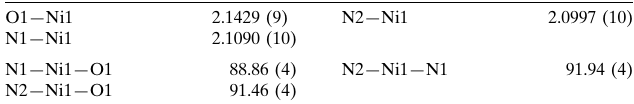
Selected geometric parameters (A˚ , (cid:3) ).